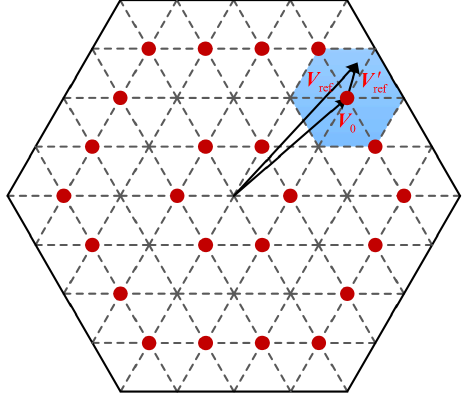
Figure 5. The distribution of the generalized zero vectors for the five-level converter.